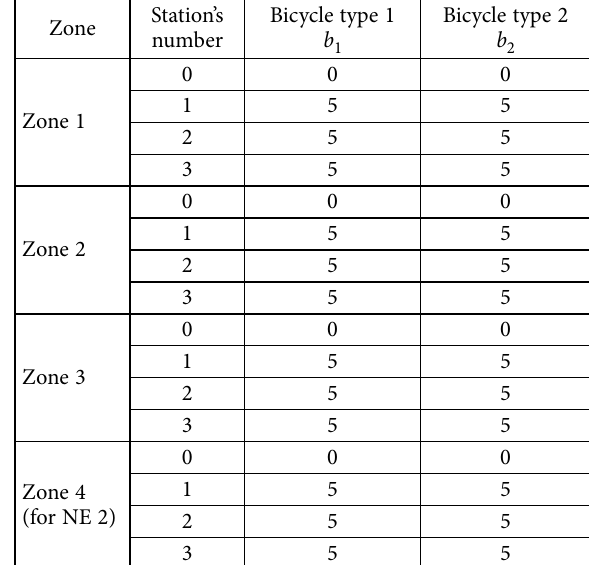
Table 10. Safety stock for bicycle types in stations for both numerical